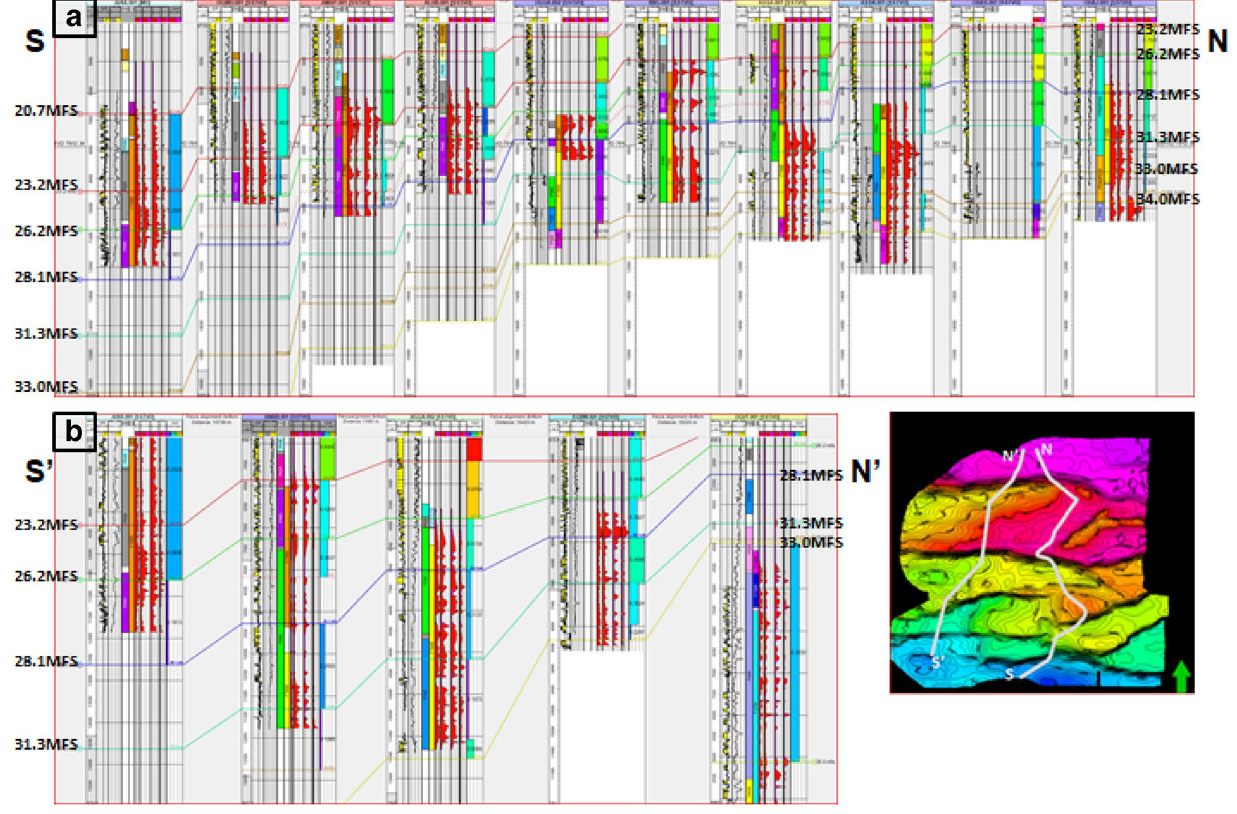
Fig. 4 Regional sequence stratigraphic correlation along two north to south direction lines a , b with the wells used in this